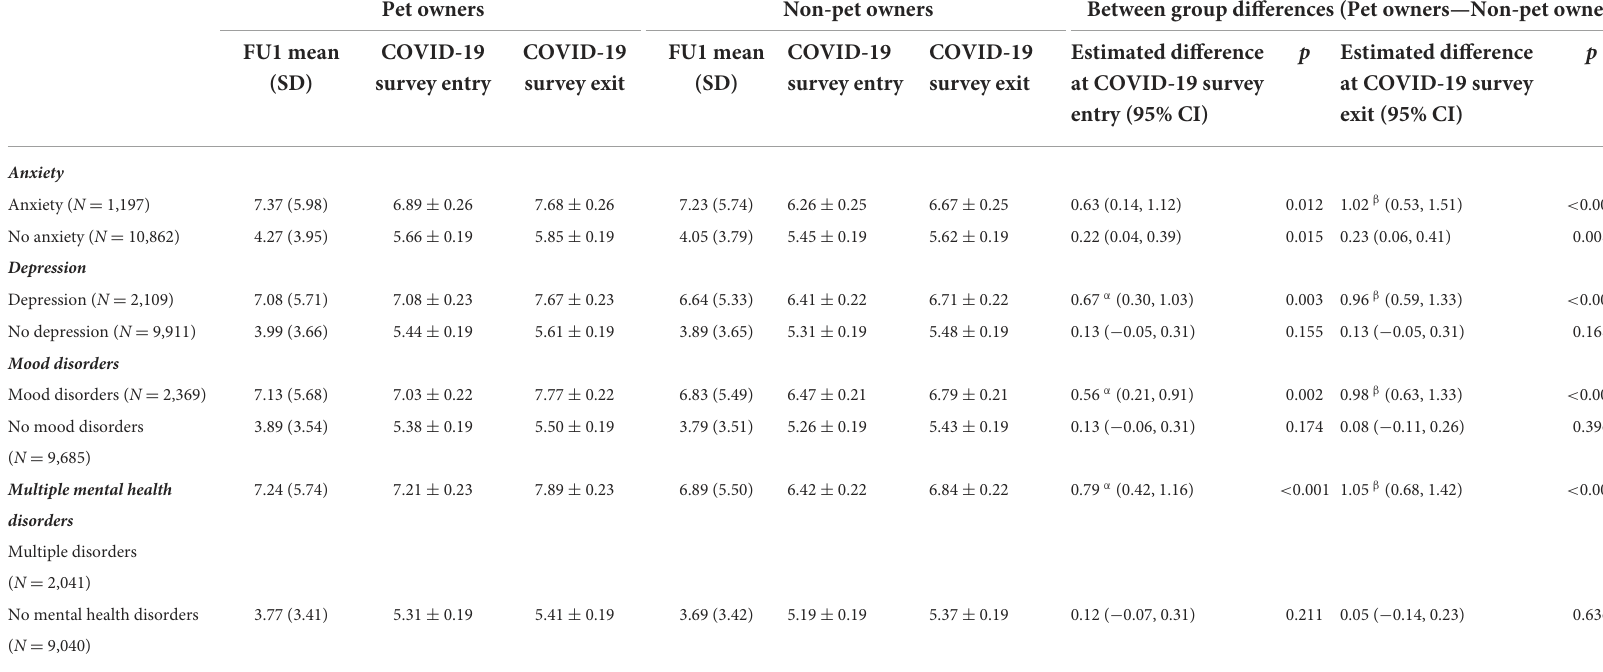
TABLE 4 Estimated marginal means and standard errors for changes in 10-item Center for Epidemiological Studies Depression Scale (CESD-10) score at first follow-up ([FU1]; 2015–2018), and COVID-19 Survey entry (April 15–May 30, 2020) and exit (September 29–December 29, 2020), based on self-reported mental health disorder status and pet